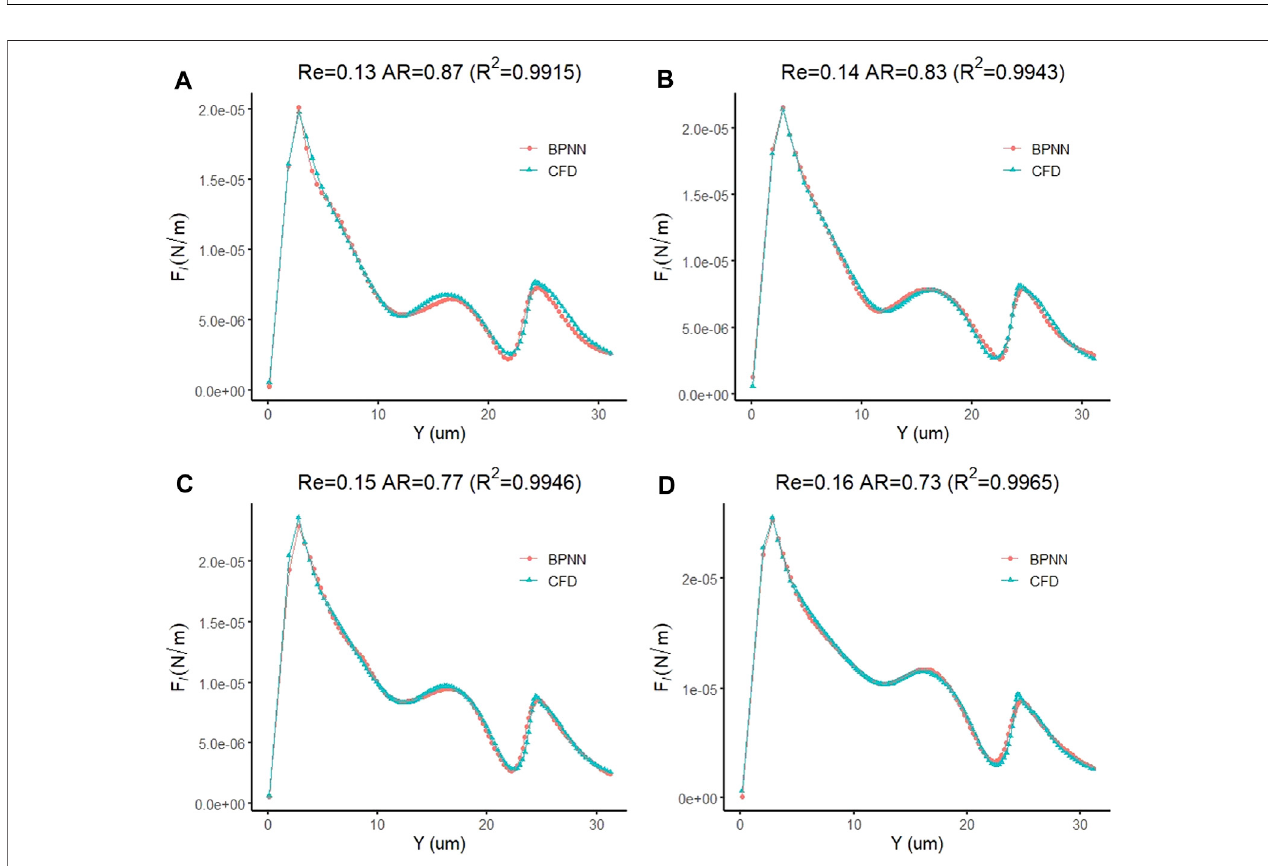
FIGURE13| Predictionaccuracytestoftheleukocytetransmigrationpredictionmodelforthepredictionof fl uidliftforcesoncells (A) Re=0.13,AR=0.87; (B) Re= 0.14, AR = 0.83; (C) Re = 0.15, AR = 0.77; (D) Re = 0.16, AR = 0.73.